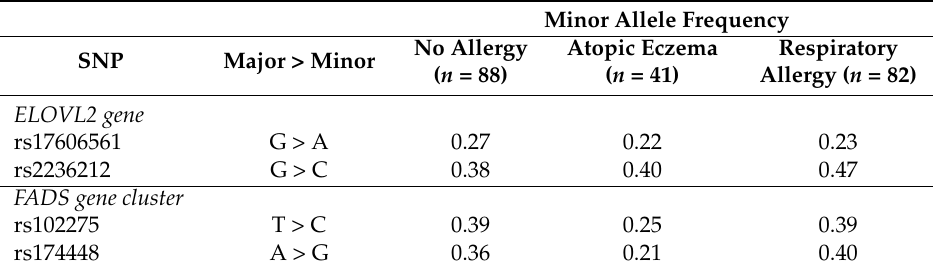
Table 4. Minor allele frequency in non-allergic and allergic subjects in this